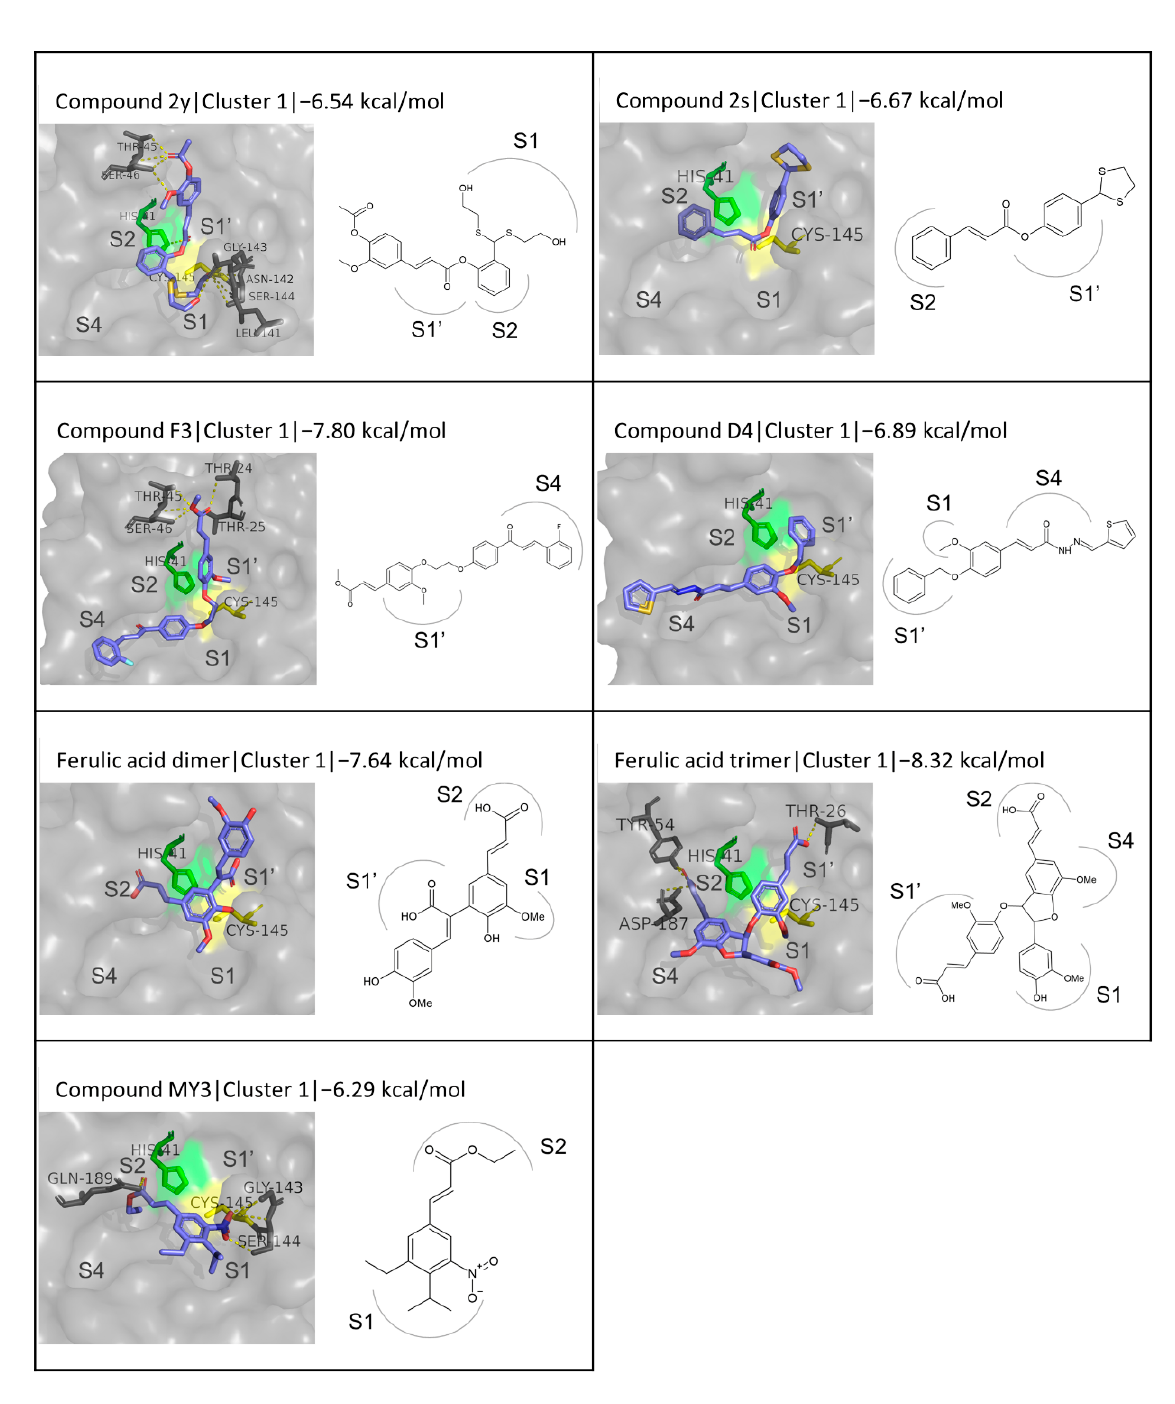
Figure 11. Structures and binding modes of chemically synthesized FA derivatives in the active site of M pro .